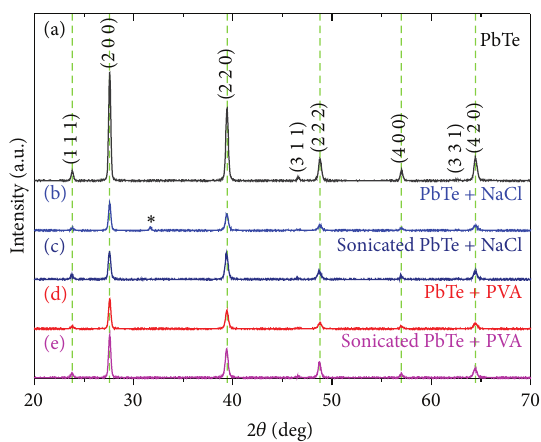
Figure 1: X-ray diffraction patterns of (a) PbTe PbTe + NaCl (b) before and (c) after sonication, and (d) PbTe + PVA (d) before and (e) after sonication. Asterisk ( ∗ ) represents NaCl phase and green dotted lines are guidelines for peak